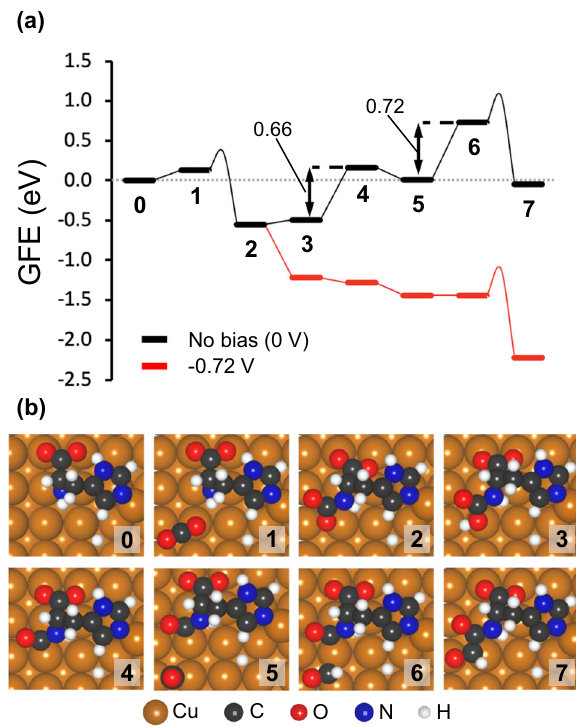
Fig.4|InitialreactionstepsduringCO 2 RRoverhistidine-Cu/Cu(100)substrate calculated by DFT. a Gibbs free energy (GFE) diagram and the b snapshots of the fi rst few surfaces intermediates in the histidine-assisted CO 2 RR mechanism. The GFE diagram was calculated from the reference state ( 0 ), which consists of a his- (Fig. S6.8), whilethe coupling between *CO and *CHO is endergonicby tidine-Cu/Cu(100)showninFig.S6.2b,agas-phaseCO 2 molecule,andanadsorbed 0.10eV and has a barrier of 0.63eV. *CO. In con fi gurations (1 – 4), the *CO molecule adsorbed on a bare Cu(100) sub- strate is omitted for clarity, however, the energy has been added to each system accordingly.This*COapproachestheHist – COintermediate(5)andbecomes*CHO after a CPET step (5 ! 6), where the thermodynamic barrier Δ G 5 ! 6 of 0.72eV can be overcome with applied bias (red line). The newly formed *CHO species may couple with the co-adsorbed Hist – COintermediate througha C – C bond to form7. The intermediates of the surface reactions (1 ! 2 and 6 ! 7) are connected by smooth lines, from which the energy level of the TS may be inferred (the highest point of the smooth